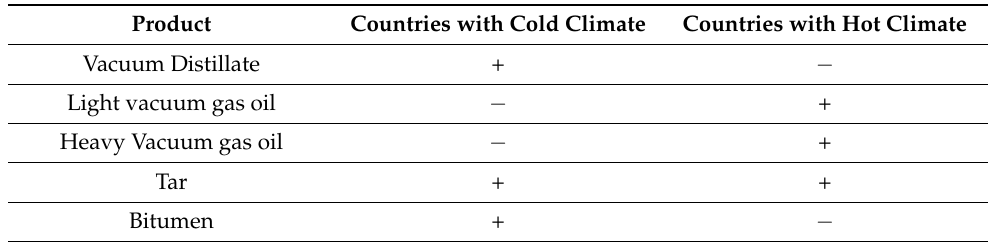
Indonesia. The schemes were compared according to the product streams produced on the vacuum column; the “+” sign signifies a greater preference for the production of the product, while the “ − ”indicates a small number of blocks involved in the development of this product. Table 1. Differences between typical schemes of vacuum units of mini-refineries in countries with hot and cold climates.